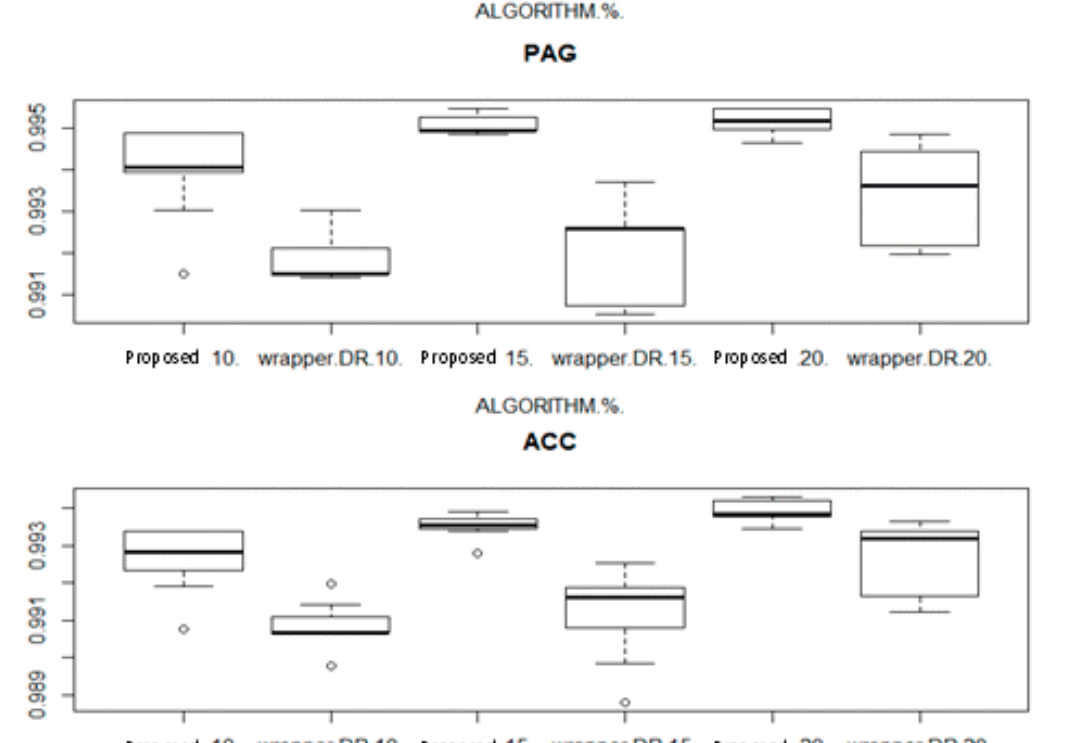
Figure 11. ETS/CSI/PAG/ACC result in binary: Proposed vs PCA.